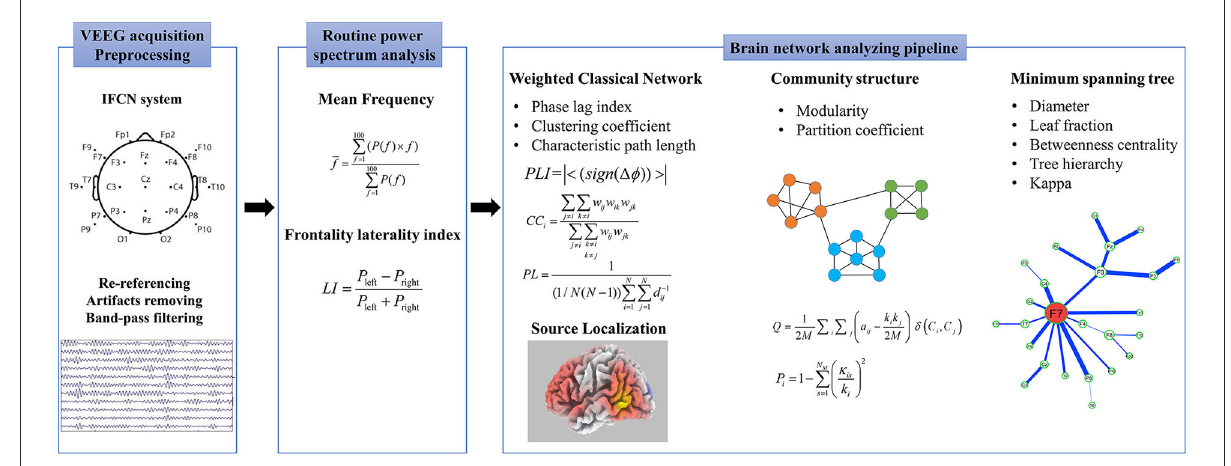
FIGURE1 Protocol for electroencephalography processing and analyzing.